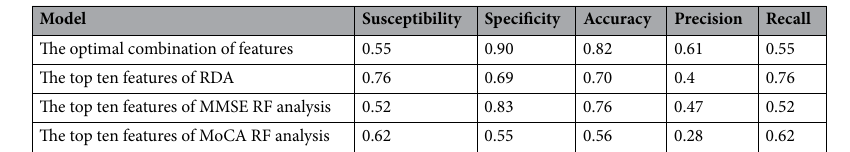
Table 7. Validation dataset validated all the combinations of features (MMSE). MMSE Mini-Mental State Examination; MoCA Montreal Cognitive